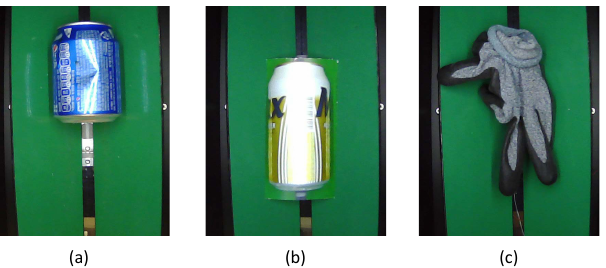
Figure 5. Captured images in the dataset. ( a ) is a target class sample of a can. ( b ) is a visually similar fraud sample of printed can. ( c ) is a non-target sample of